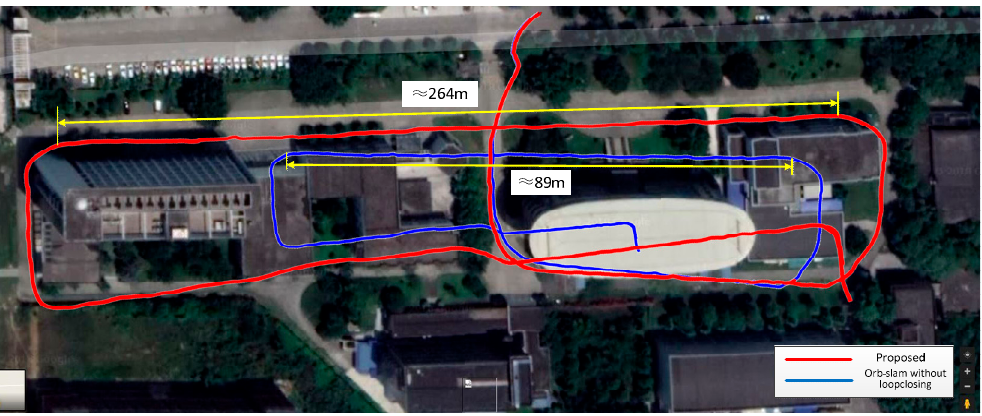
Figure 10. Trajectory in scene 3. The red trajectory is basically the same as the real one, while the blue trajectory has a large scale drift